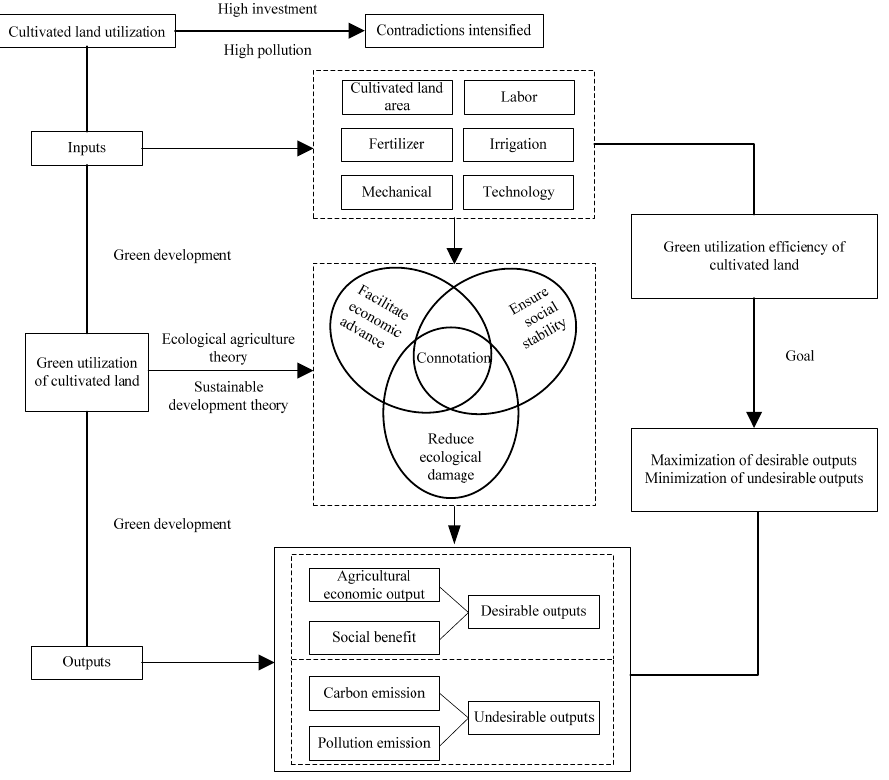
Figure 3. Theoretical analysis framework of the green utilization efficiency of cultivated land (GUECL).